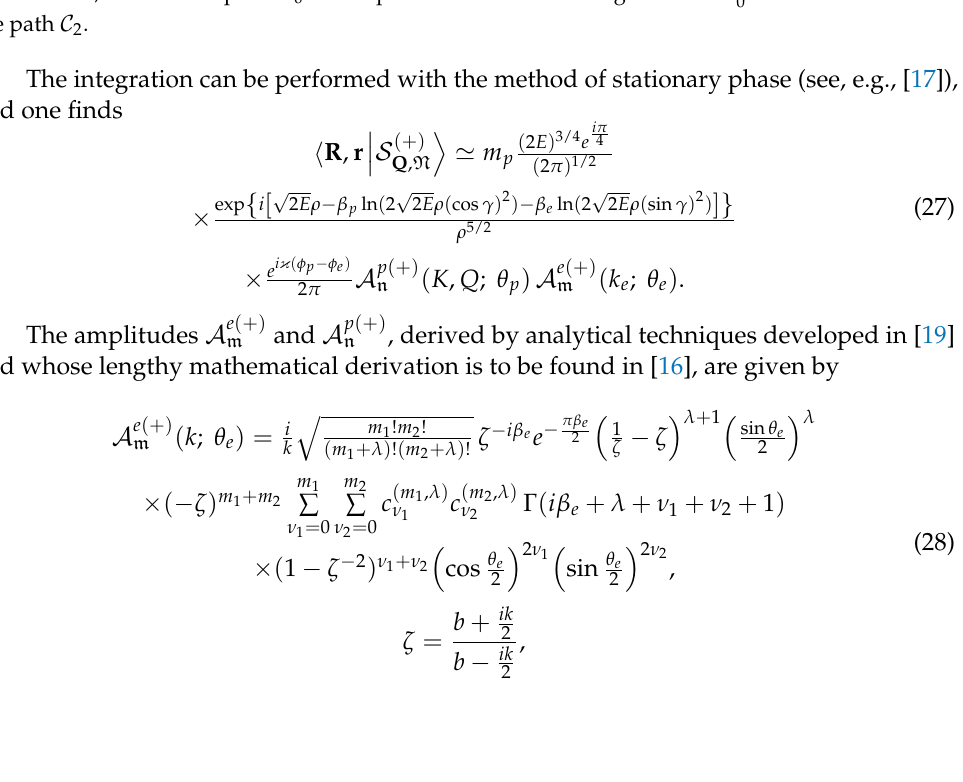
(+) . The path C 1 is obtained by a negative angle ϕ 0 (+) therewith follows 0